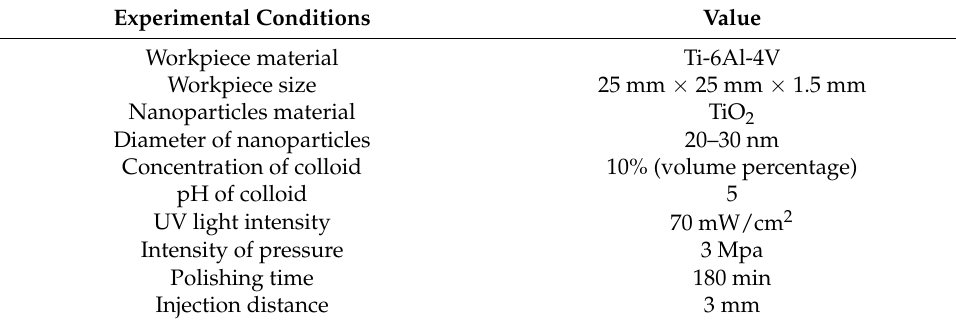
Table 1. Relevant parameters in the polishing